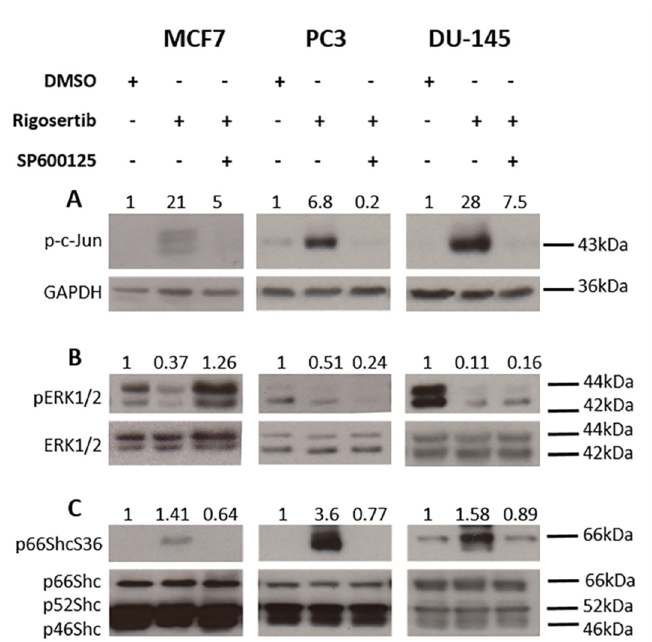
Figure 3. JNK1 / 2 regulation of p66Shc activity in tumor cell lines upon Rigosertib treatment. Representative Western blots demonstrating the e ff ects of SP600125 (20 µ M, JNK inhibitor) treatment before Rigosertib application (50 µ M for 18 h) on cJun ( A ), ERK1 / 2 ( B ), and p66ShcS36 phosphorylation ( C ) in MCF7, PC3, and DU-145 cells. Numbers on top of the blot indicate the fold change in protein phosphorylation upon Rigosertib treatment (normalized to loading control) relative to DMSO (solvent)-treated control samples. All experiments have been repeated at least three times with consistent results. A representative blot is shown.